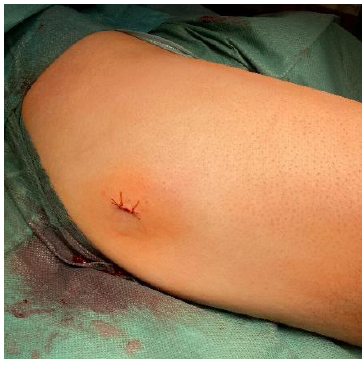
Figure 6. Intraoperative X-ray of the proximal femur showing: ( a ) disruption of the nidus with a drill; ( b ) positioning of the RFA (Radiofrequency abaltion) probe in the nidus; ( c ) the RFA probe inserted in the working cannula.